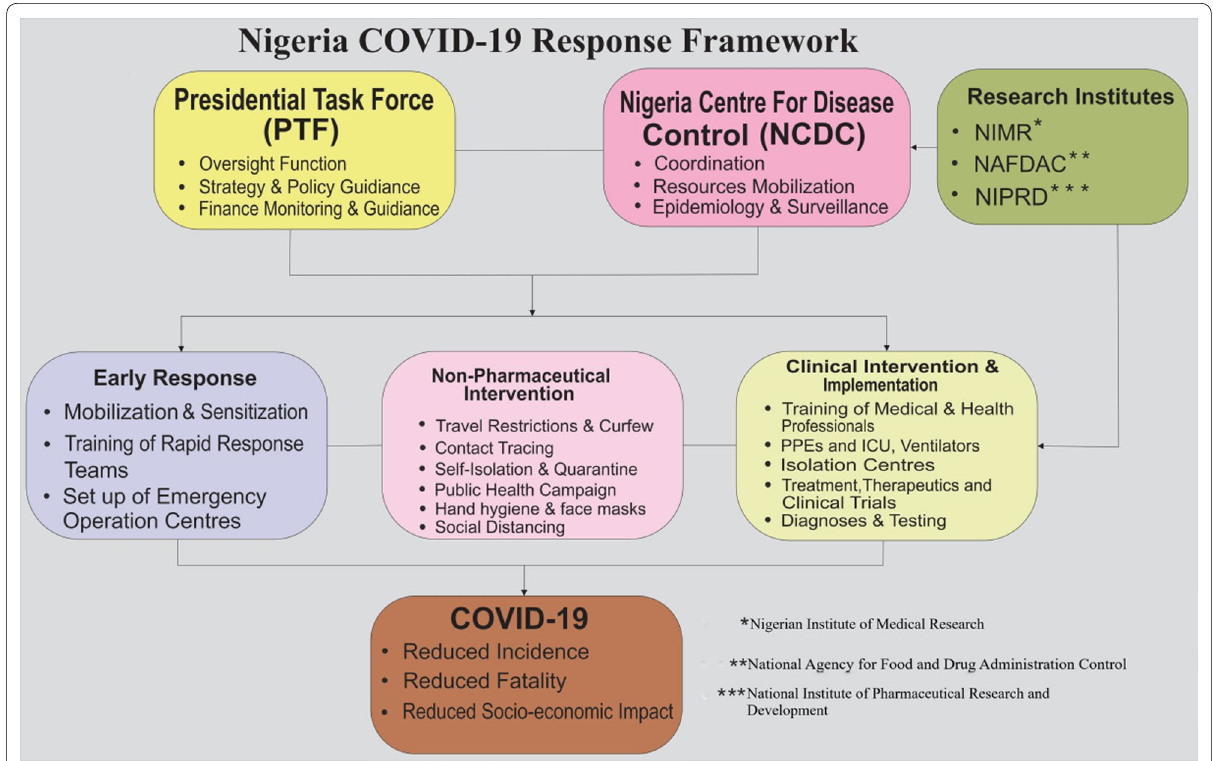
Fig. 1 Nigeria COVID-19 response